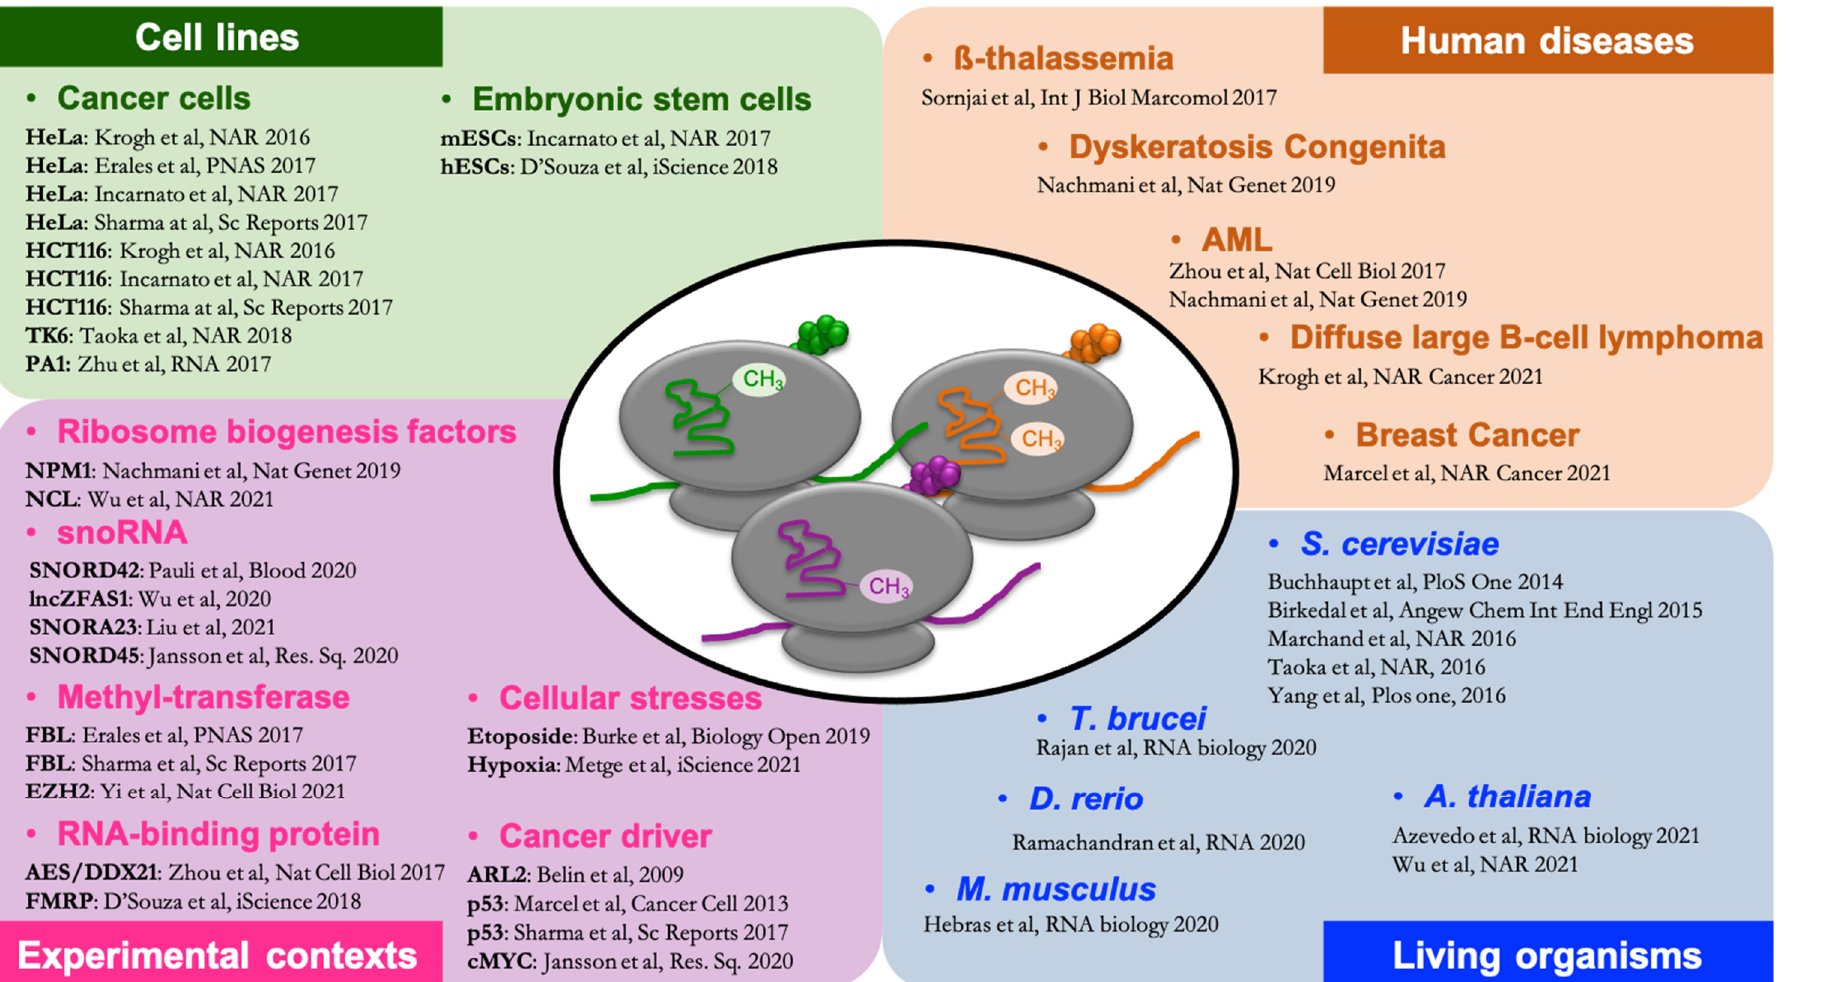
Figure 2. Variability of rRNA 2 ′ Ome in living organisms, biological processes, and human diseases.